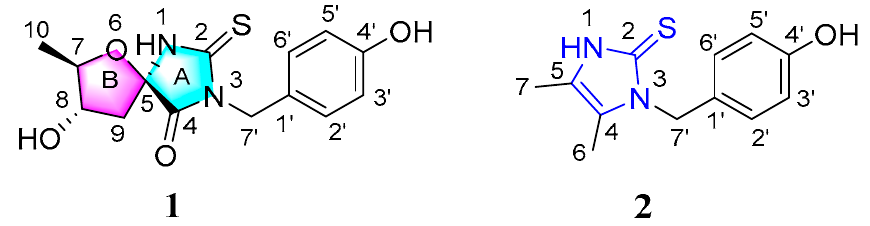
Figure 1. Structures of Compounds 1 and 2